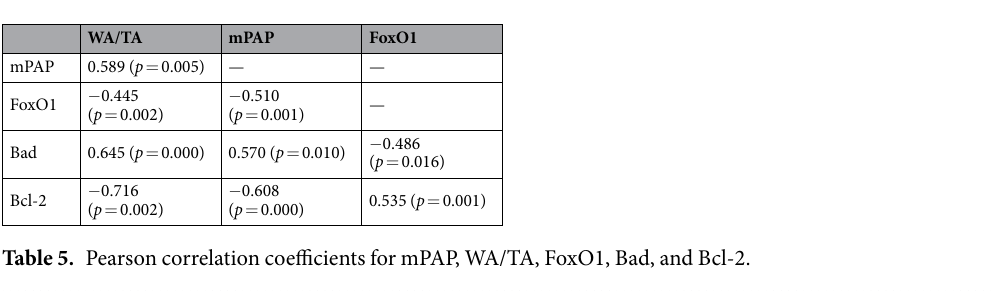
the WA/TA ratio and mPAP. Taken together, these data suggest that apoptosis plays an important role in vascular remolding following pulmonary embolism. The precise mechanisms need to be further investigated. Expression of FoxO1 in pulmonary embolism-induced vascular remolding. The FoxO transcrip- tion factors play critical roles in cell proliferation, apoptosis, and differentiation by regulating the PI3K/Akt sign- aling pathway and its downstream genes (e.g., genes encoding Bcl-2/Bcl-XL, Bad, glycogen synthase kinase) 26–28 . FoxO1 is expressed in the embryonic vasculature and FoxO1 gene defects cause embryonic death, suggesting that FoxO1 is essential for maintenance of embryonic vasculature and normal physiological function. In the presence of vascular endothelial growth factor (VEGF), FoxO1-deficient endothelial cells exhibit clearly different mor- phological changes compared to the normal endothelial cells, indicating that FoxO1 is required for the normal physiological function of endothelial cells. In the present study, we found that pulmonary embolism decreased the mRNA and protein expression of FoxO1 compared to the sham group, possibly through a mechanism whereby downregulation of FoxO1 promotes proliferation of endothelial cells leading to vascular remodeling. In a study in umbilical veins, activation of the PI3K/Akt pathway in endothelial cells induces the deregulation of FoxO1 and